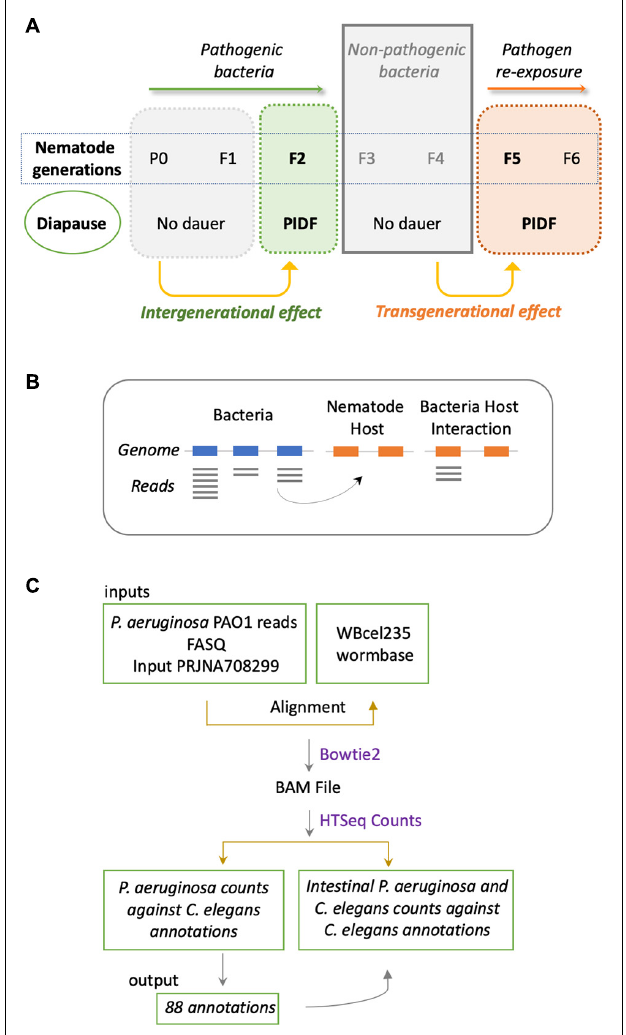
FIGURE 1 | (A) Schematic representation of the inter- and transgenerational paradigm of pathogen-induced diapause formation (PIDF). Animals chronically feeding on pathogenic bacteria such as P. aeruginosa PAO1 form dauers in the second generation of exposure to the bacteria. Re-exposure to pathogens after two generations on non-pathogenic bacteria triggers the immediate formation of the dauer larvae. (B) Representation of the putative mechanism of interaction based on matching sRNA sequences from bacteria with genomic sequences of C. elegans . (C) Methodological flow to address the mechanism proposed in panel (B) .